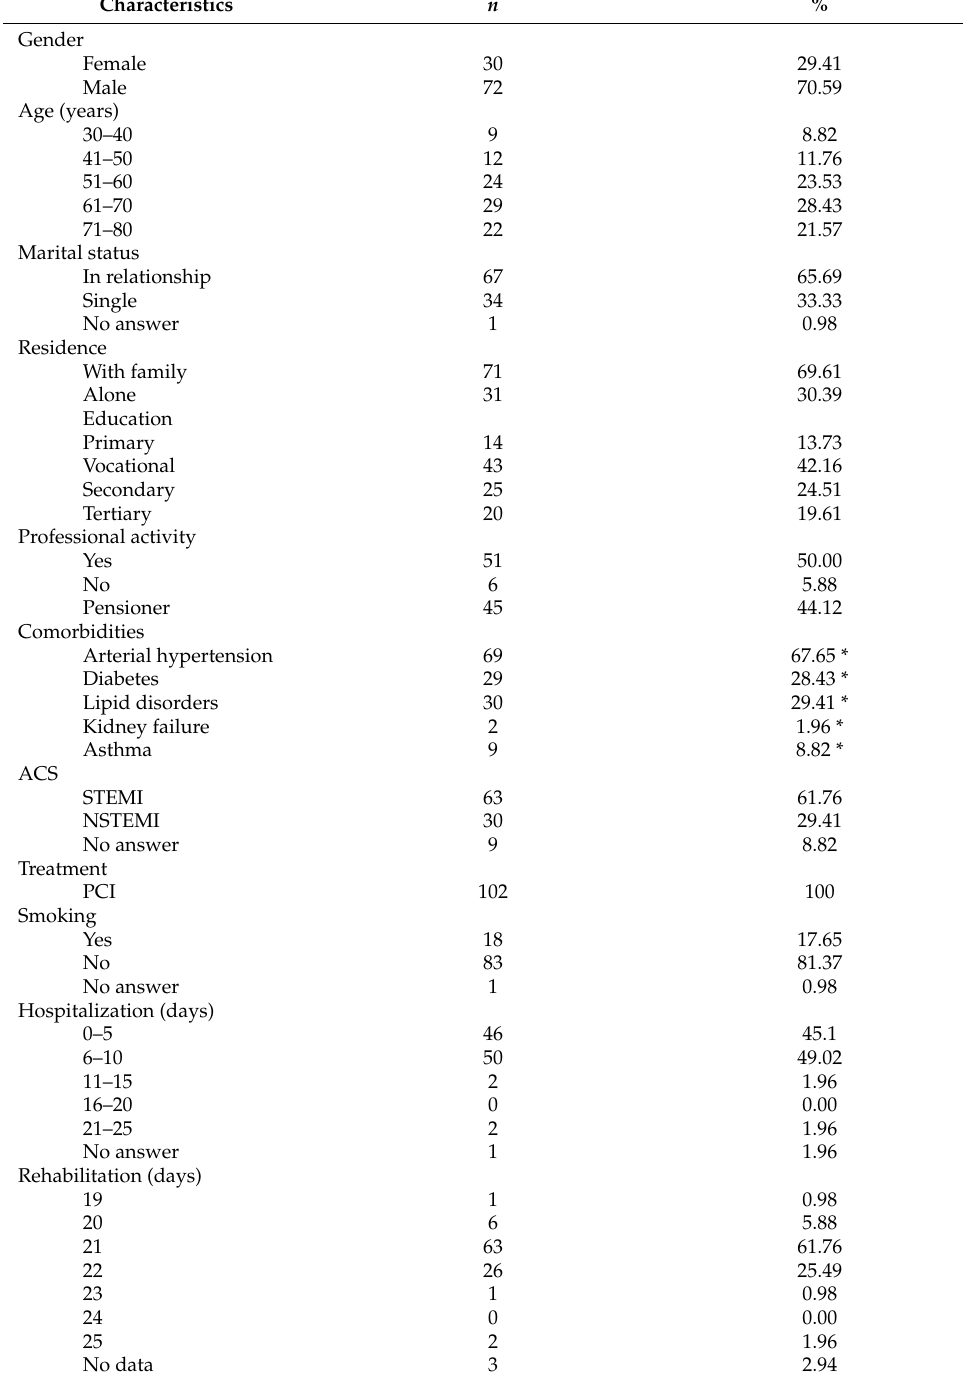
Table 1. Socio-demographic and clinical characteristics of myocardial infarction (MI) patients.